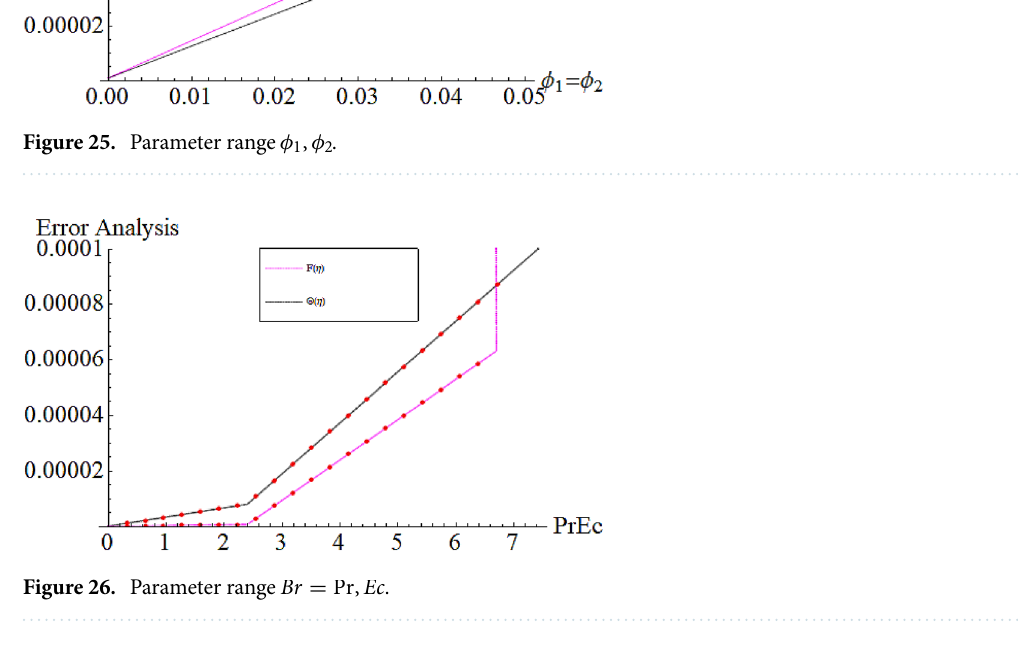
Figure 26. Parameter range Br